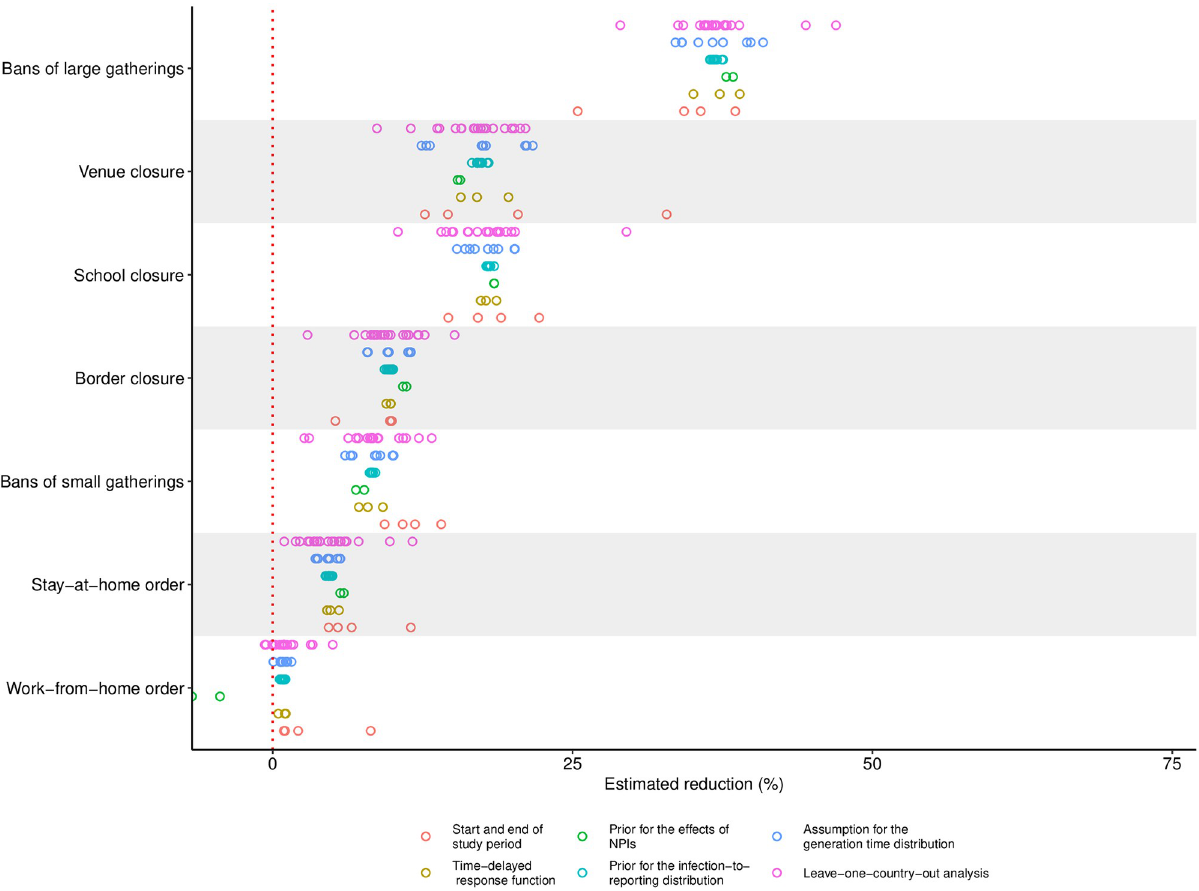
Fig 5. Summary of the sensitivity analysis. Sensitivity of the estimated effects of NPIs (posterior mean as dots) to different data preprocessing, varying modeling and prior choices, and data exclusion. Section 6 in S1 Appendix presents all individual sensitivity analyses in detail.